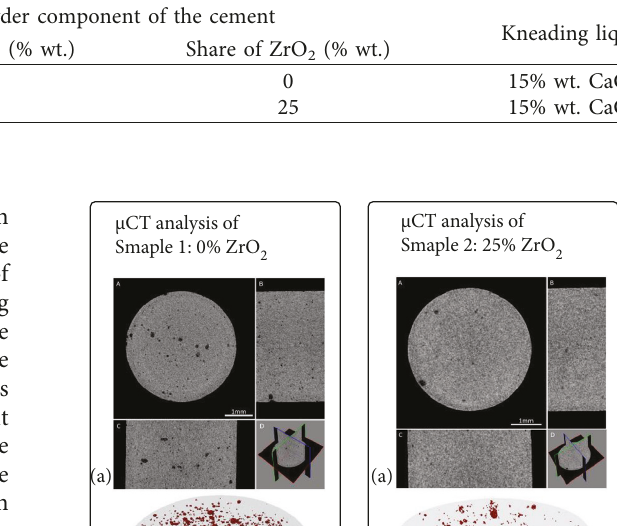
Kneading liquid